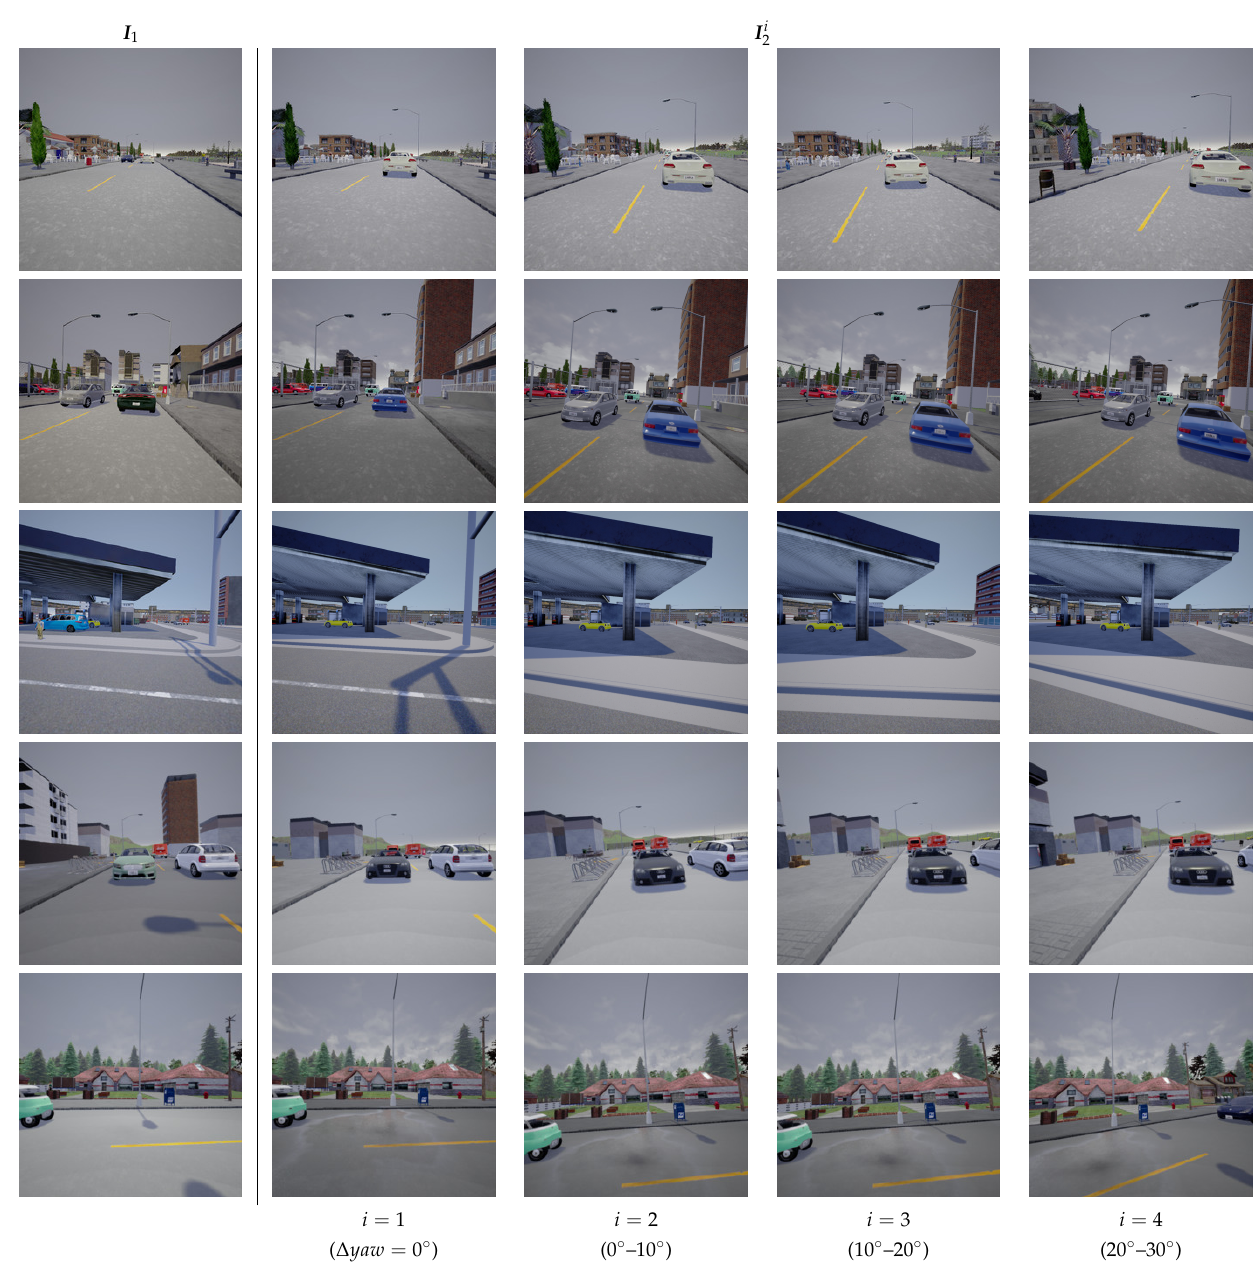
Figure 7. Examples from the SOCD dataset. I 1 are images before any changes and I i after the changes. For i = 1, there were no viewpoint differences between I 1 and I i a viewpoint difference existed between I 1 and I i for i = 2,3 and 4 and ranged from 0 ◦ to 10 ◦ , from 10 ◦ to 20 ◦ and from 20 ◦ to 30 ◦ ,